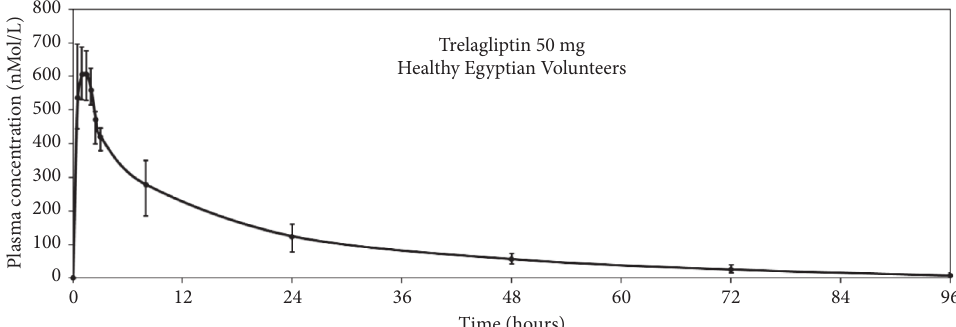
Figure 10: The plasma concentrations versus time curve of TLN after administration of Zafatek ® tablet (50mg